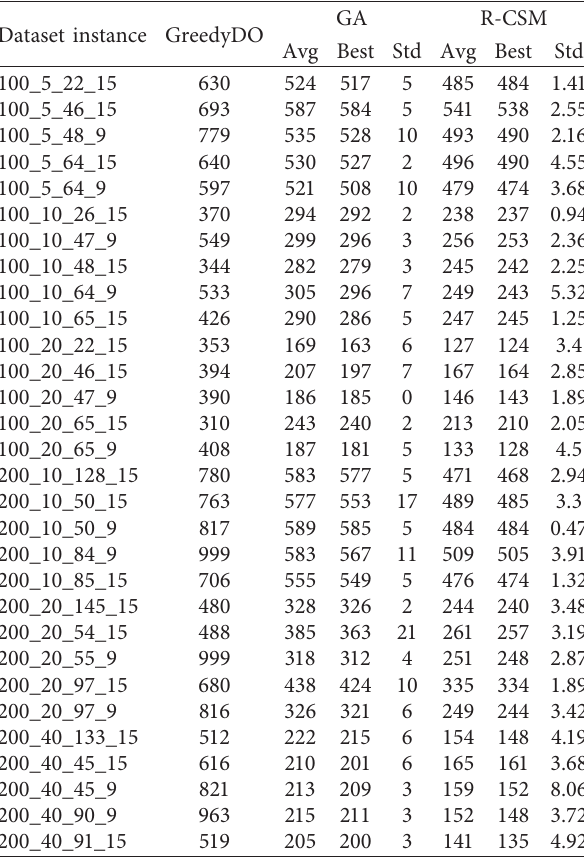
Table 8: d36 iMOPSE dataset. Table 9: Makespan of algorithms (in